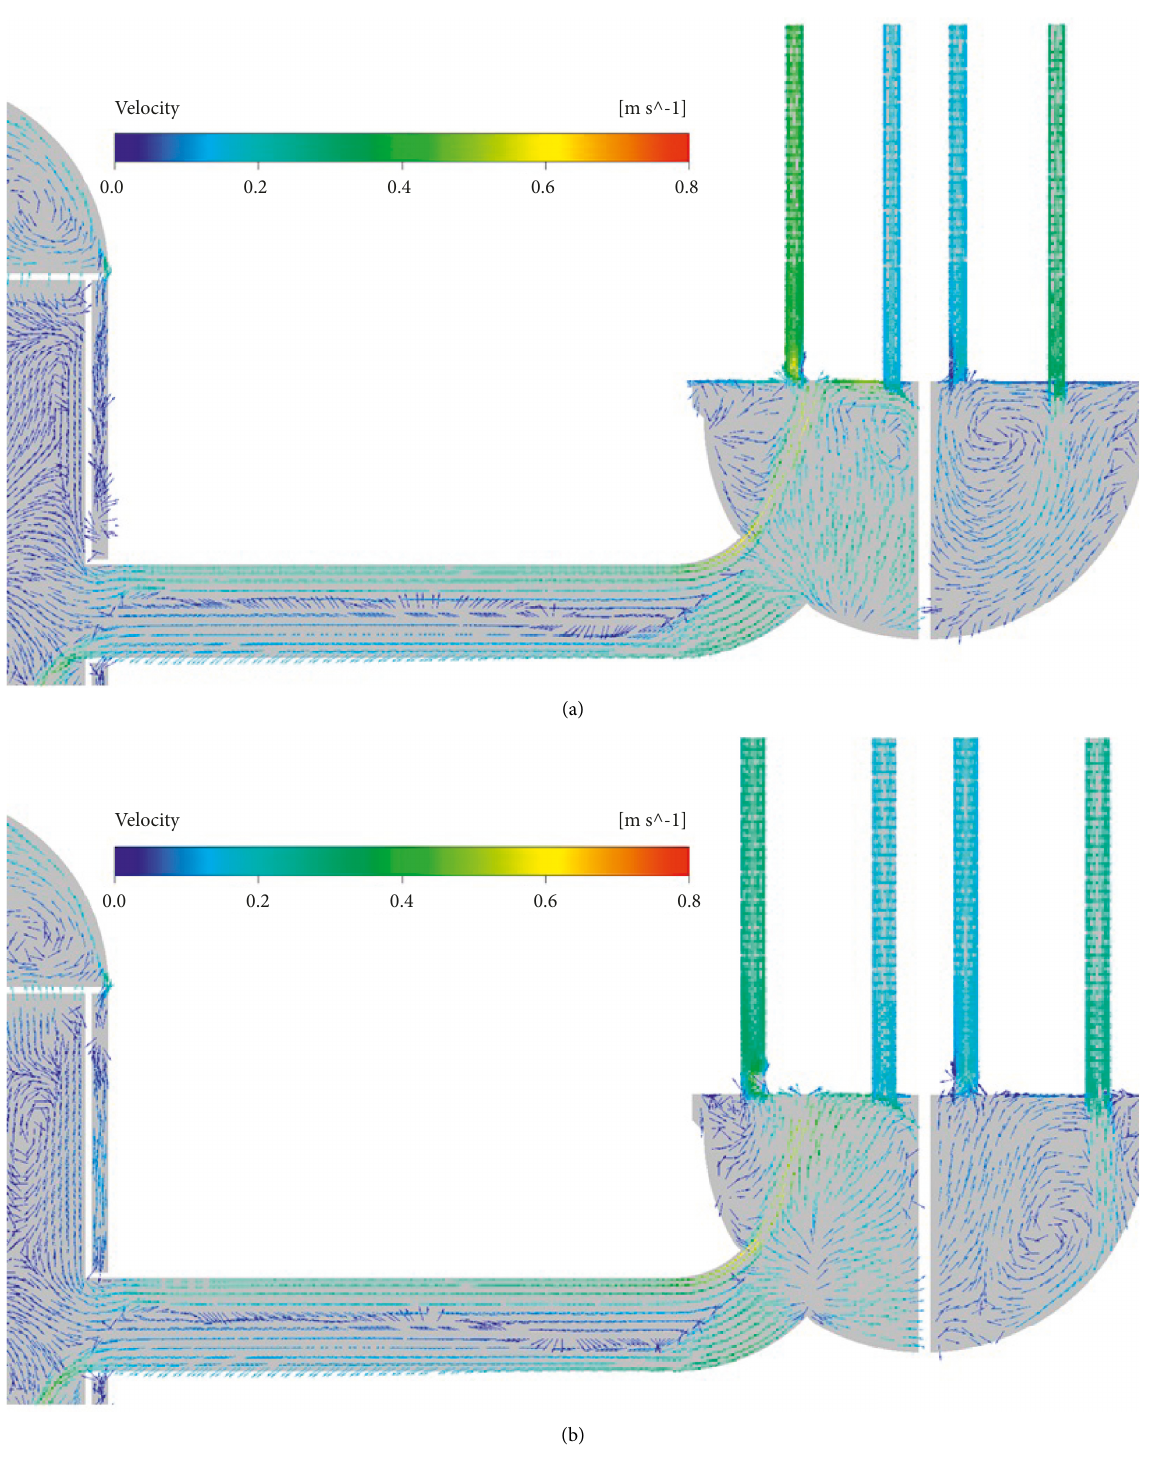
Figure 14: Velocity vector on symmetry plane (models 2 and 3). (a) Model 2 and (b) model